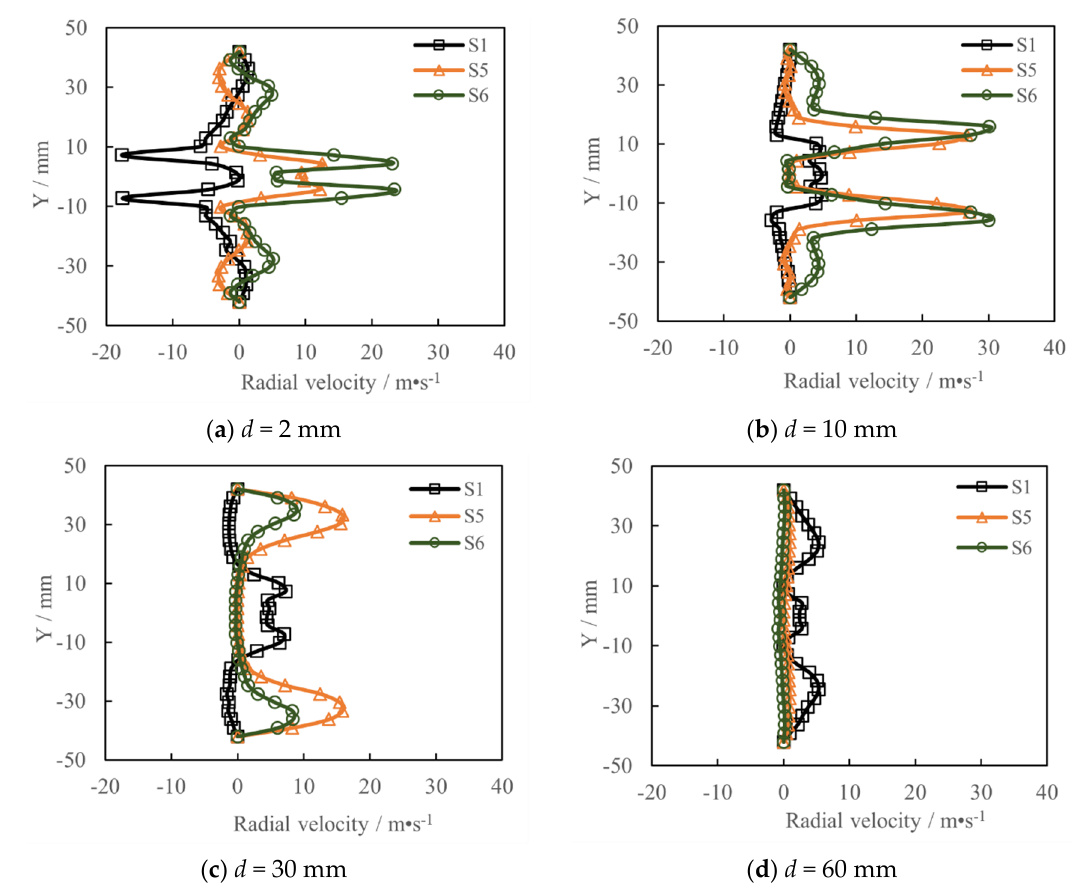
Figure 15. Radial profiles of radial velocity. Figure 14d indicates that at 60 mm downstream of swirler outlet, the negative axial velocity at the central axis of Scheme S5 increases, compared with that at d = 30